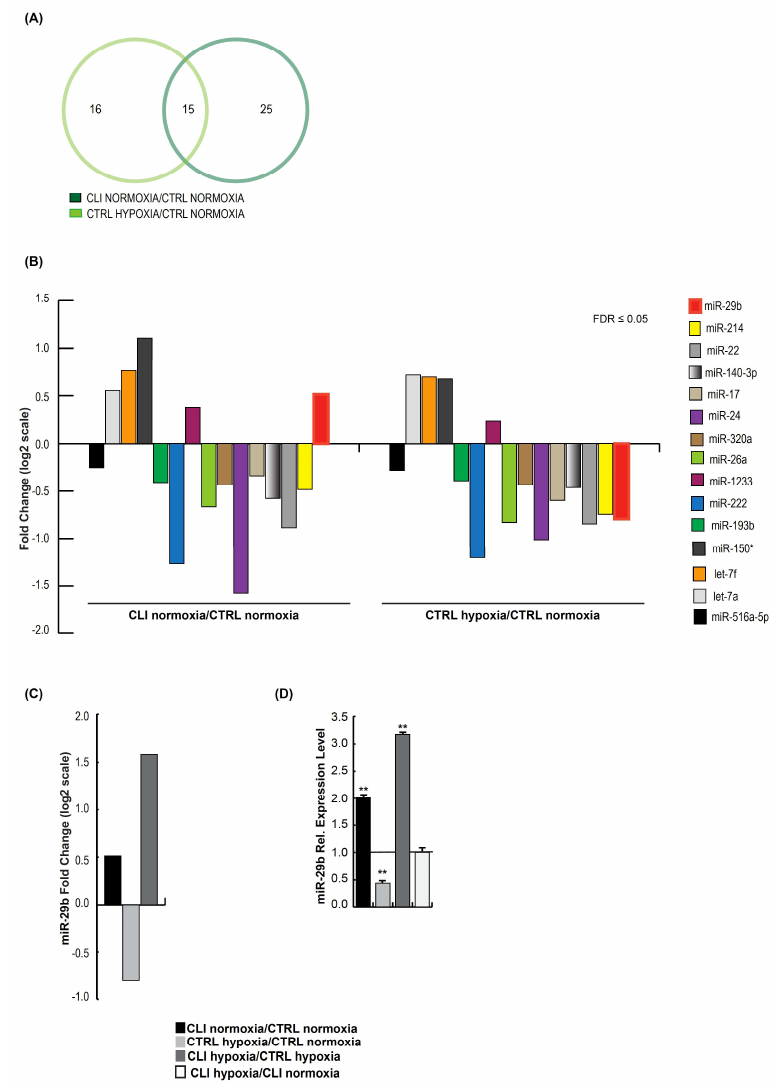
Figure 2. ( A ) Venn diagram showing 15 common miRNAs between CLI NORMOXIA/CTRL NORMOXIA vs CTRL HYPOXIA/CTRL NORMOXIA. ( B ) Fold change of microarray expression levels in log2 scale of 15 miRNAs commonly altered in CLI normoxia/CTRL normoxia vs. CTRL hypoxia/CTRL normoxia ( FDR ≤ 0.05). ( C ) Fold change of microarray expression levels in log2 scale of miR-29b in CLI normoxia/CTRL normoxia, CTRL hypoxia/CTRL normoxia and CLI hypoxia/CTRL hypoxia. ( D ) Relative expression levels of miR-29 analysed by RT-PCR in CTRL HYPOXIA/CTRL normoxia, CLI normoxia/CTRL normoxia, CLI hypoxia/CTRL hypoxia and CLI hypoxia/CLI normoxia. Data are the result of three independent experiments each with three replicates, and are represented as ± SEM. RNU6B was used for data normalization for miRNA. p -value ≤ 0.01